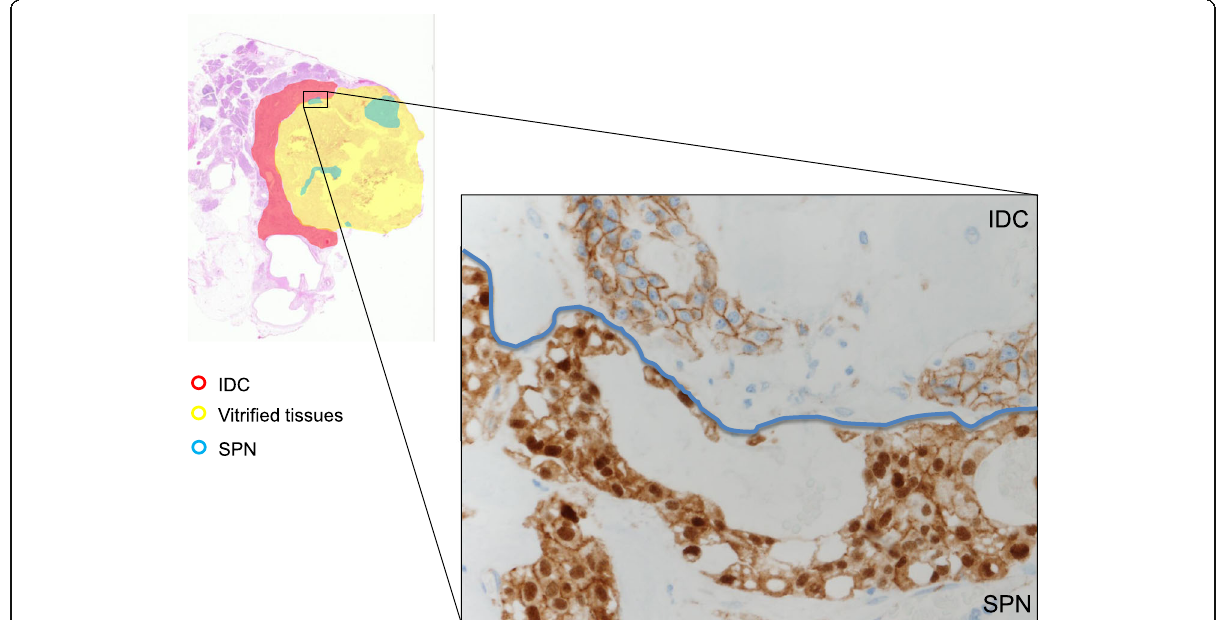
Fig. 7 Tumor mapping and histopathological findings (immunohistochemical staining). The boundary between SPN (positive β -catenin staining) and IDC (no β -catenin staining) was clear (blue